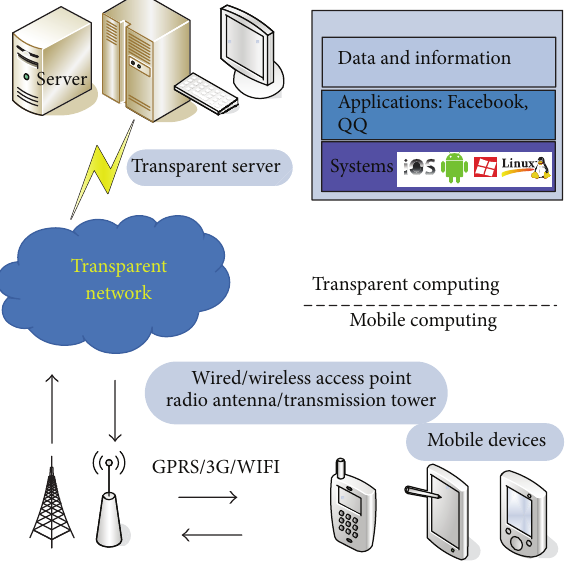
Figure 1: Framework of MTC.